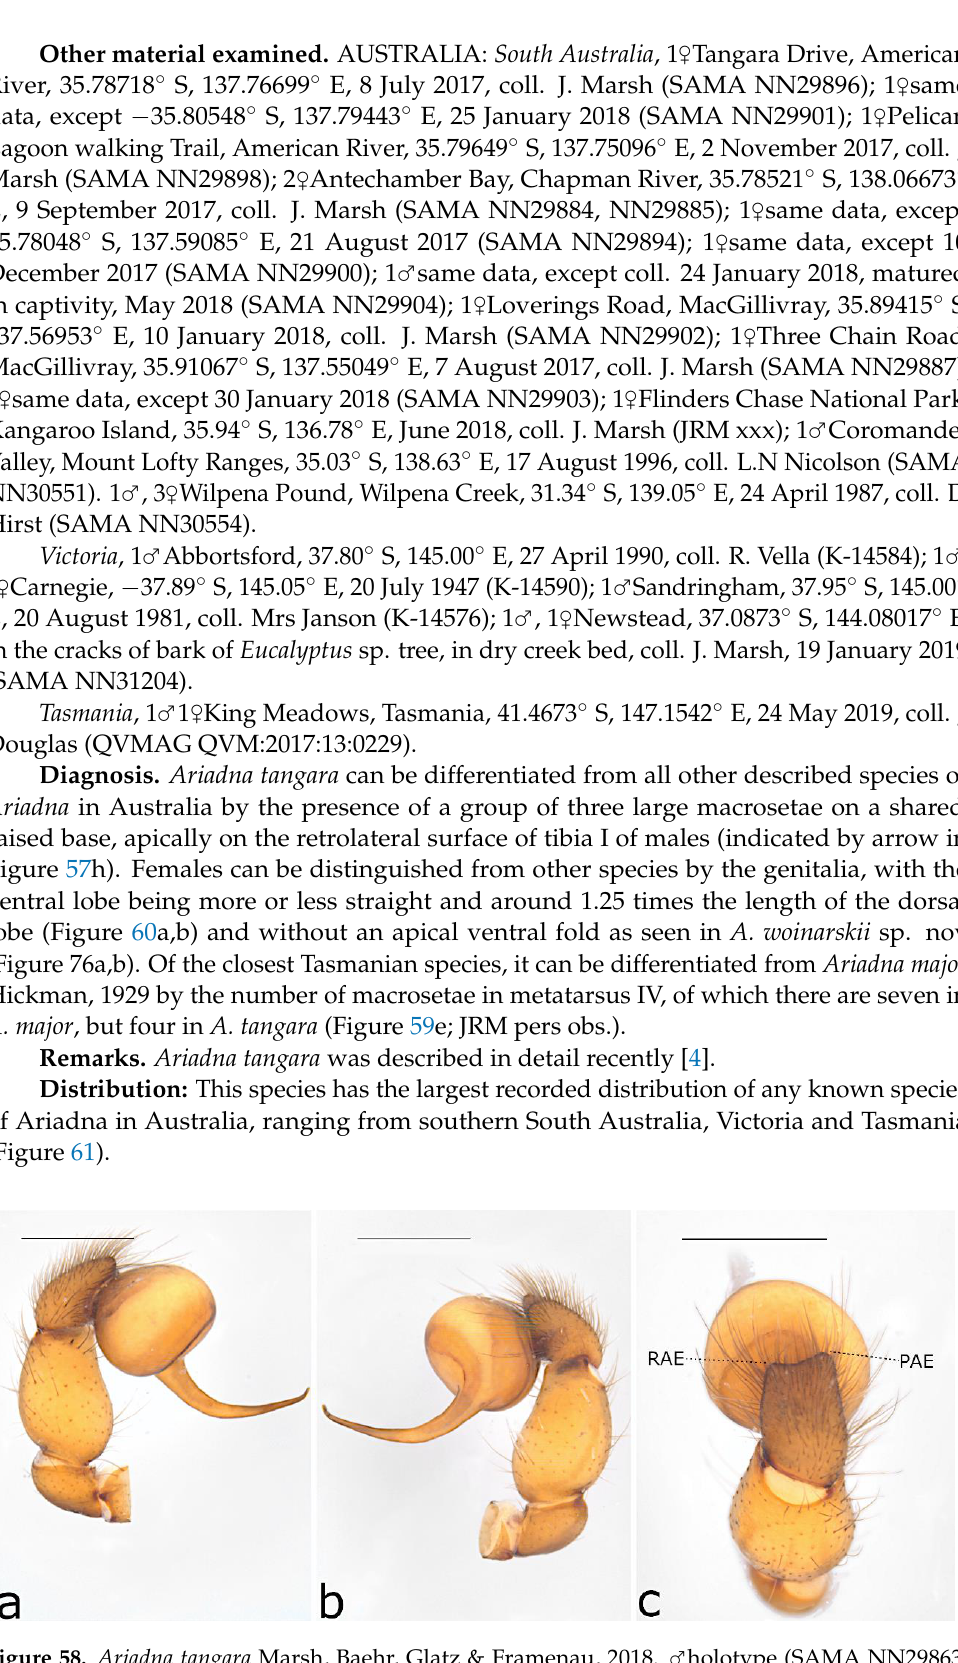
holotype (SAMA NN29863) ♂